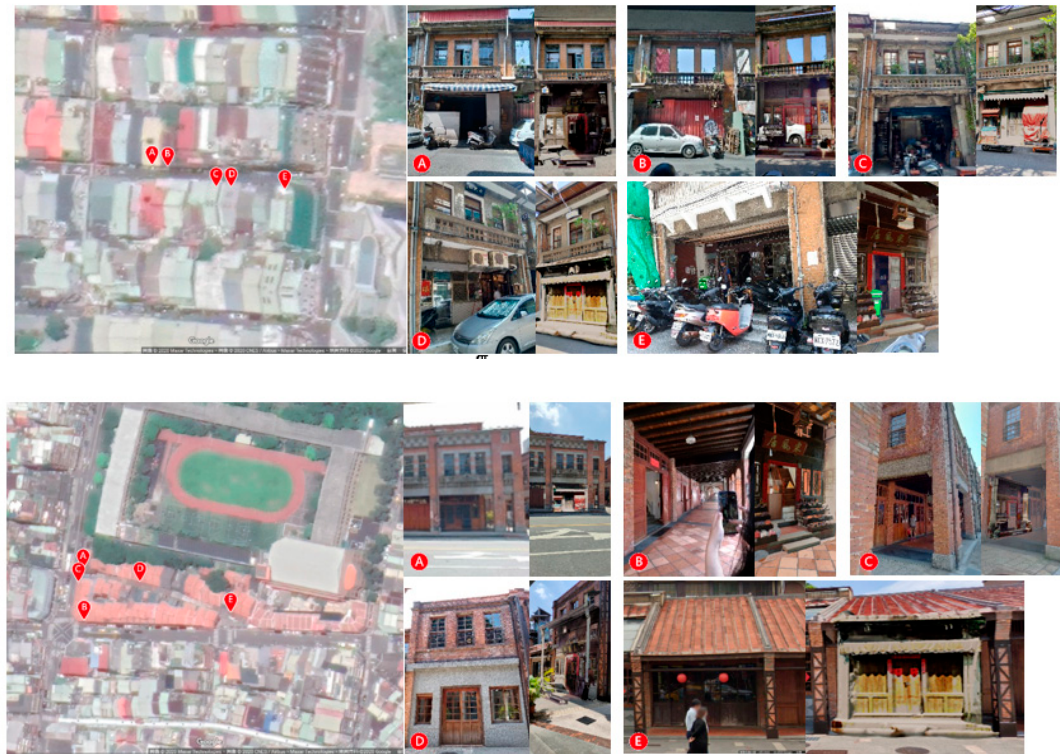
Figure 14. AR-based simulation and comparison of façades in Dihua Street, Chifeng Street, and Bopiliao, Taipei (from top to bottom ).